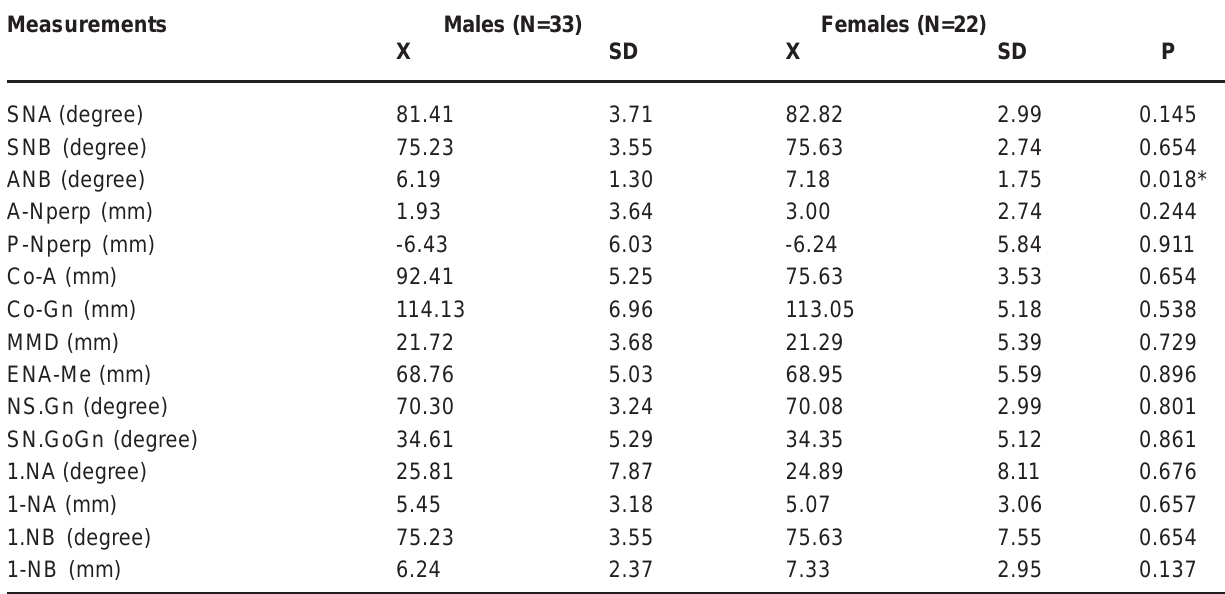
* STATISTICALLY SIGNIFICANT FOR P<0.05.